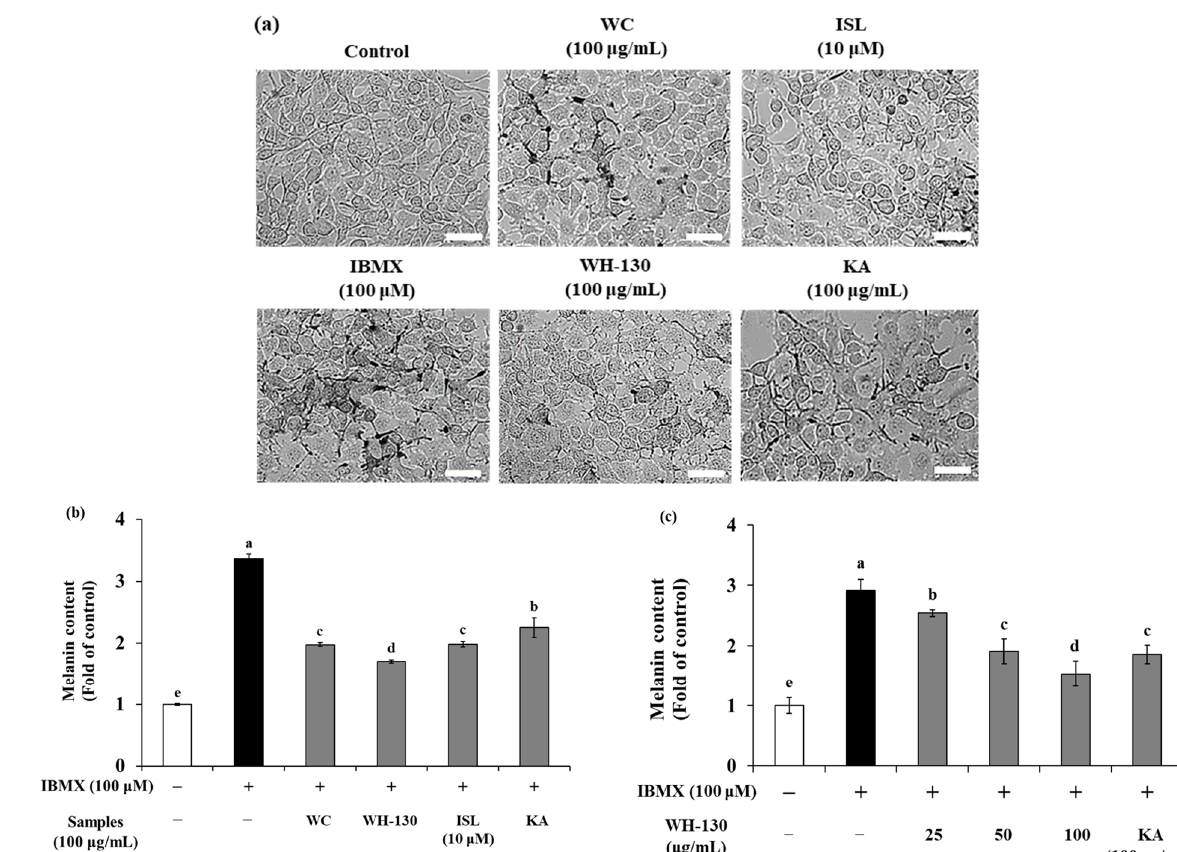
Figure 3. Cell viability associated with licorice extracts (WC and WH-130) was determined using the MTT assay. Data are expressed as mean ± SD ( n = 3). ** p < 0.01.